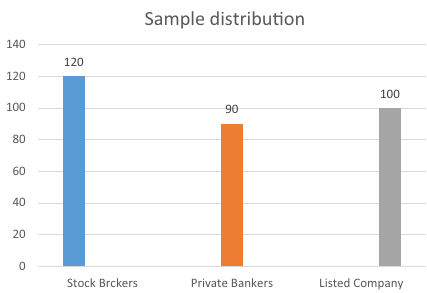
Figure 2. Sample distribution among